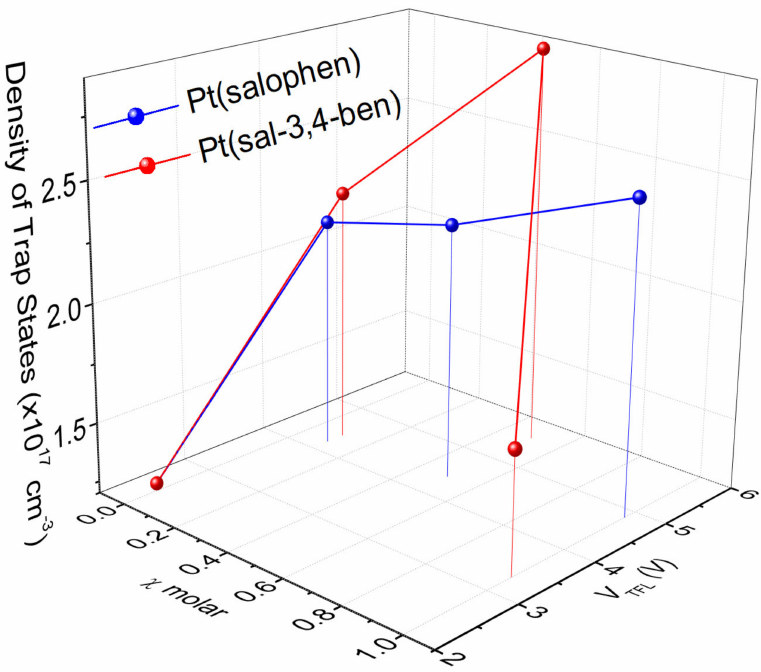
Figure 8. Density of the trap states, as determined by the VTFL data for both OLEDs’ emissive layers.